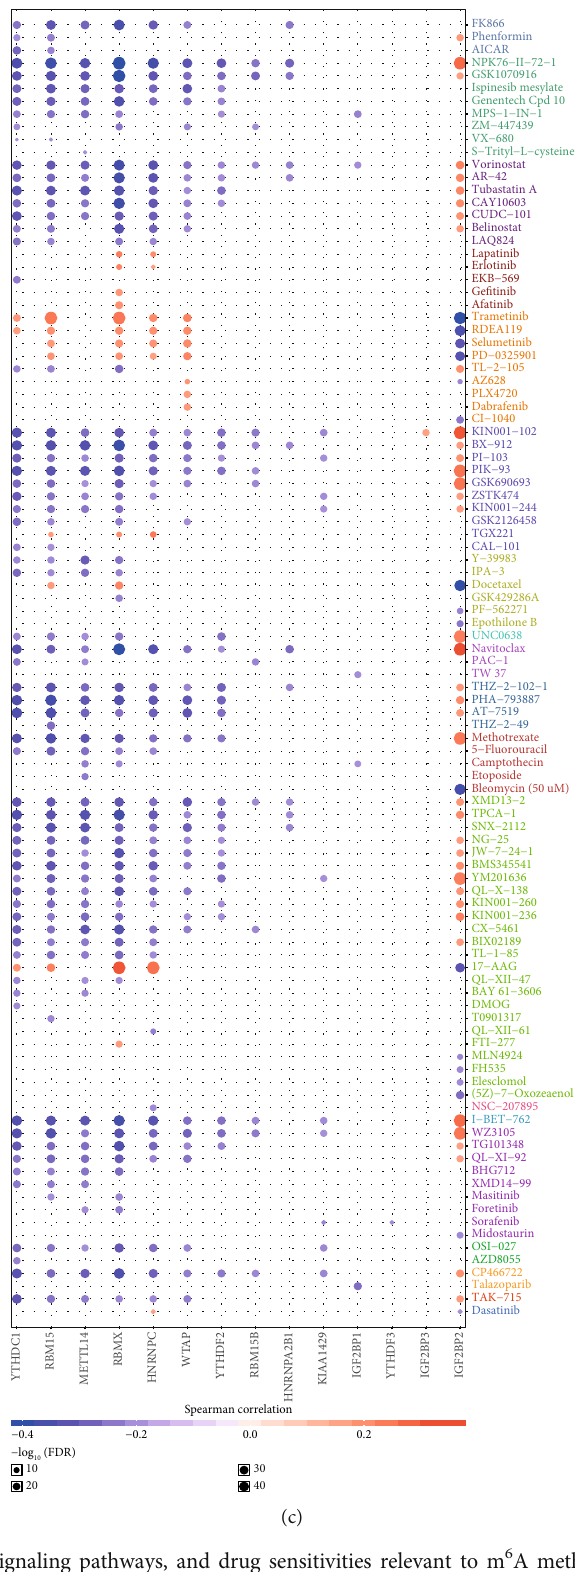
Figure 4: Physiological processes, signaling pathways, and drug sensitivities relevant to m 6 A methylation regulators. (a) E ff ect of m 6 A methylation regulators on physiological processes and signaling pathways. A: active; I: inhibited; the darker the color, the stronger the inhibition (blue) or activation (red). If a regulator activates a process or a pathway, the activation index is higher than the inhibition index. On the contrary, if the inhibition index has the highest value, then the process is inhibited. (b) Pie chart showing the results from (a) (red: activation; green: inhibition). (c) Drug sensitivities of m 6 A methylation regulators (ordinate axis: various drugs; abscissa axis: